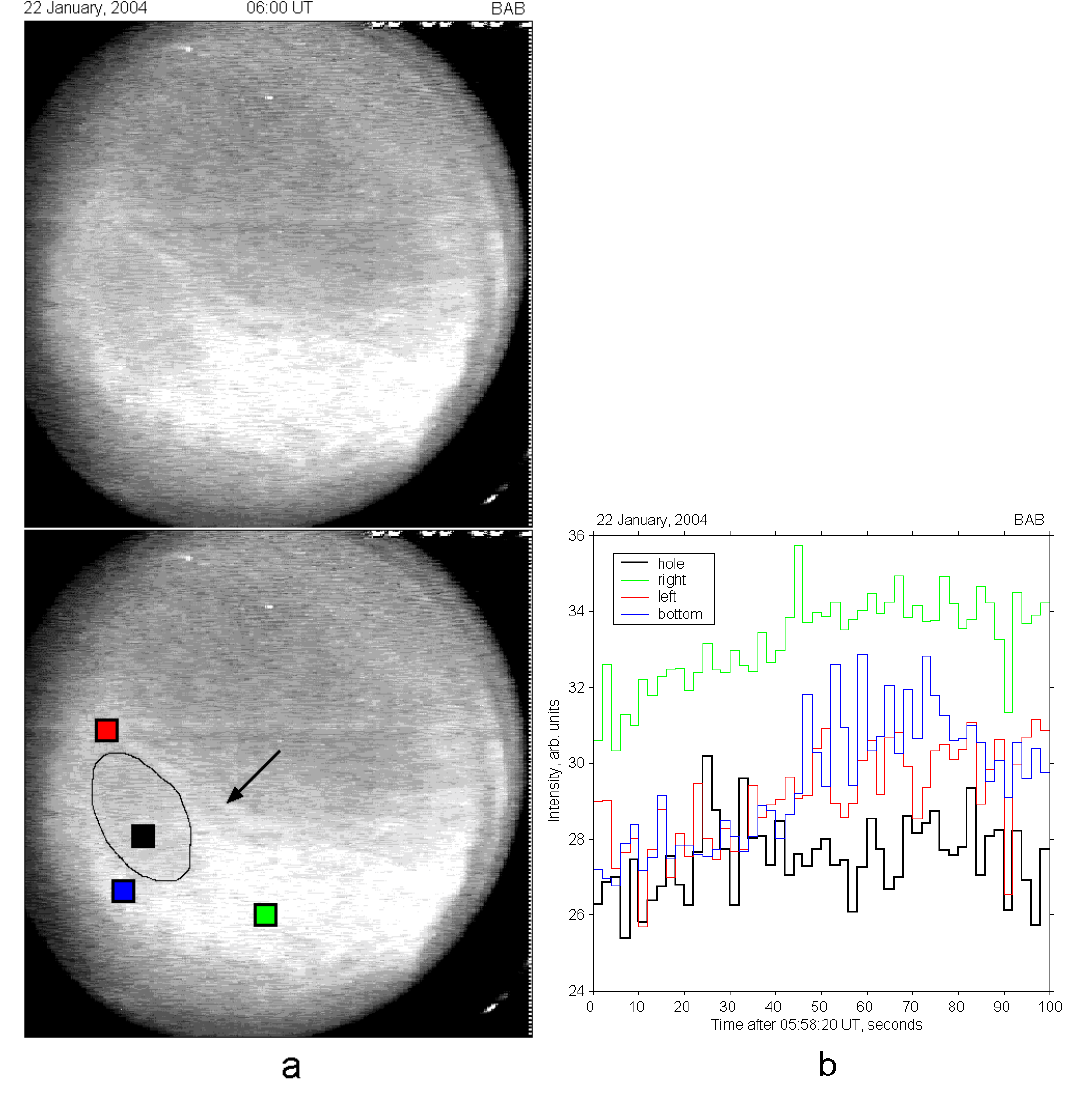
Fig. 7. The dark hole (outlined, in the lower image) in the enhancing diffuse auroras (a) and the sky luminosity variations in the square areas indicated in the lower image of the upper panel (b) . Black arrow indicates on the faint arc discussed in the